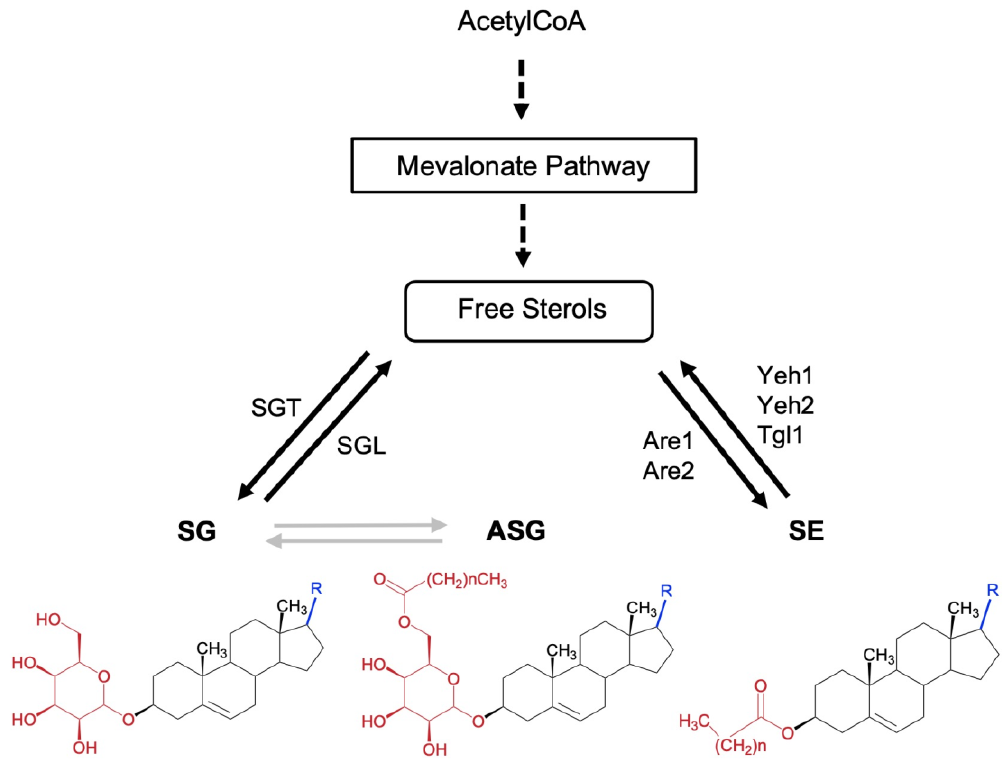
Figure 1. Schematic overview of conjugated sterol metabolism in fungi. The chemical structure of free and conjugated sterols sterylglucosides (SG), acyl Sterylglucosides (ASG), and sterol esters (SE). Dashed arrows indicate multiple steps. The position of the enzymes sterol glycosyltransferase (SGT) and sterylglucosidase (SGL) is indicated. SGs are characterized by having a sugar linked to the C3 hydroxyl group of the sterol moiety through a β -glycosidic bond. ASGs are derivatives of SGs in which the hydroxyl group of the C6 position of the sugar moiety is acylated by sterol glycoside acyltransferase (SGA), however, no SGA has been characterized in fungi to date. Gray arrows represent enzymatic pathways still to be characterized. In SEs the hydroxyl group at the C3 position is esterified with a fatty acid by sterol O-acyltransferases, named Are1 and Are2 in Saccharomyces cerevisiae , which catalyzes the formation of sterol esters and act in concert with the sterol ester hydrolases Yeh1, Yeh2, and Tgl1.